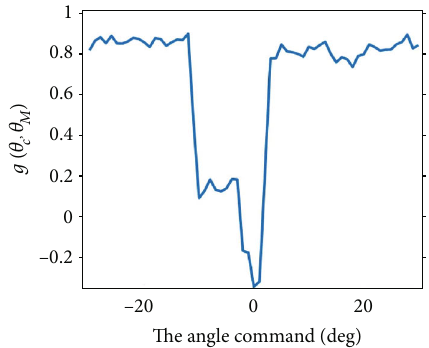
Figure 14: The value of g ð θ